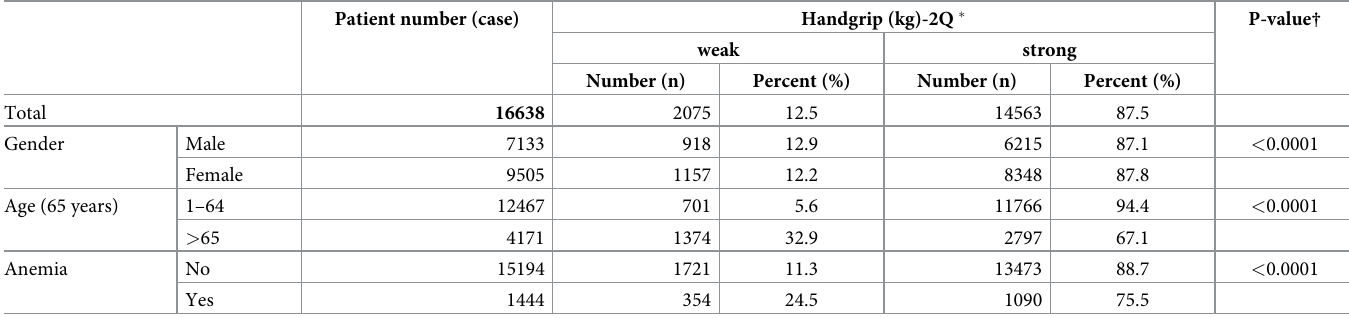
(615,680 participants, 8.5%) had anemia, and had a higher prevalence of anemia than those in the moderate (5.7%) and heavy/extreme (4.9%) daily workout groups (p < 0.001). For the nutri- tional and disease-related factors, the prevalence rate of anemia in the group with comorbid diseases was 2.5% higher than in the group without comorbid diseases (p < 0.001). For iron intake, the prevalence rate of anemia was 3.5% greater in the insufficient group than in the sufficient group (p < 0.001). Table 2 shows the description of the anemia status of the study participants and stratifica- tion based on gender and age. Anemia prevalence rate was higher in females (11.9%) and in participants � 65 years (12.7%) (p < 0.001, Table 2). Table 3 shows the description of handgrip strength in the entire participants, and stratifica- tion based on age, sex, and anemia status. Handgrip prevalence rate was higher in females (87.8%), in participants < 65 years (94.4%) and in participants without anemia (88.7%) (p < 0.001, Table 3). Table 4 shows the association between handgrip strength and anemia using logistic regres- sion analyses. The OR (odds ratio) for weak handgrip strength compared to strong handgrip strength was 2.02, 1.98, and 1.92 in Models 1, 2, and 3, respectively, showing a significant asso- ciation between weak handgrip strength and anemia (p < 0.001). The OR of underweight and overweight BMI was higher than of the normal weight, and the OR was also higher in persons with other diseases. Moreover, the prevalence of anemia was higher in persons with insuffi- cient iron, vitamin A, and vitamin C intake per day than in persons with sufficient intake (Table 4). Table 3. Description of handgrip strength in the entire participant